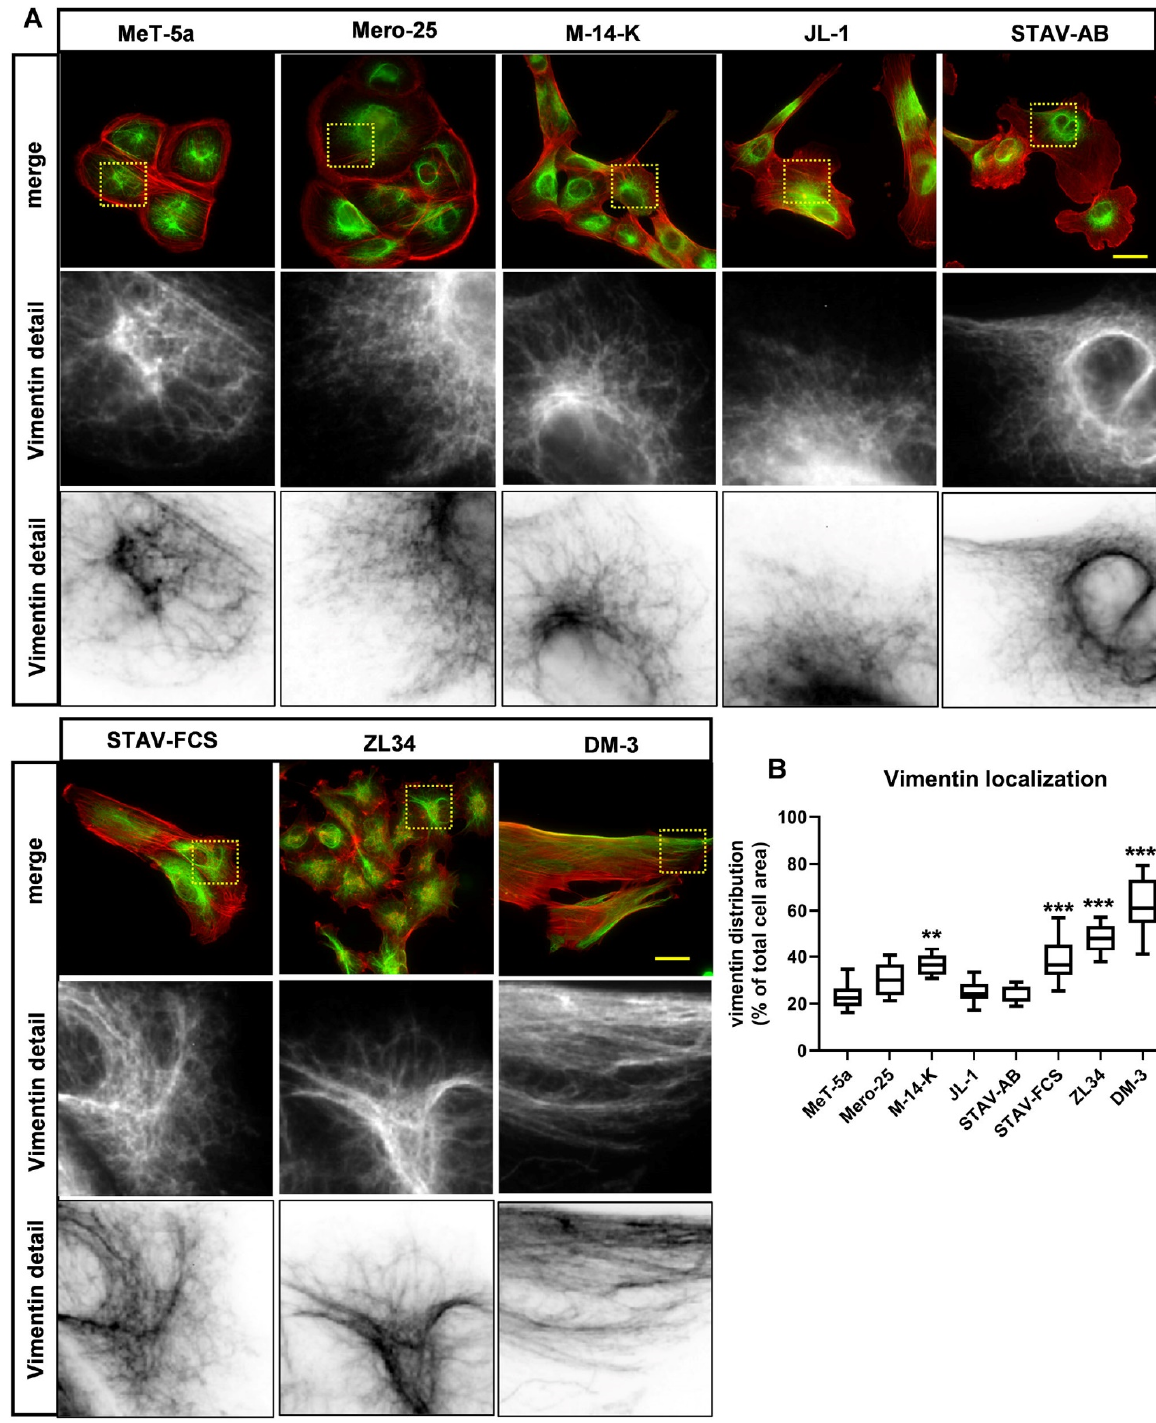
Figure 5. Organization of vimentin filaments. ( A ). Representative images vimentin intermediate filaments visualized with a mouse anti-vimentin antibody followed by an AlexaFluor488-conjugated anti-mouse antibody. Filamentous actin was visualized with TRITC-conjugated phalloidin, Scale bar, 20 µ m. ( B ). The cell area occupied by vimentin filaments